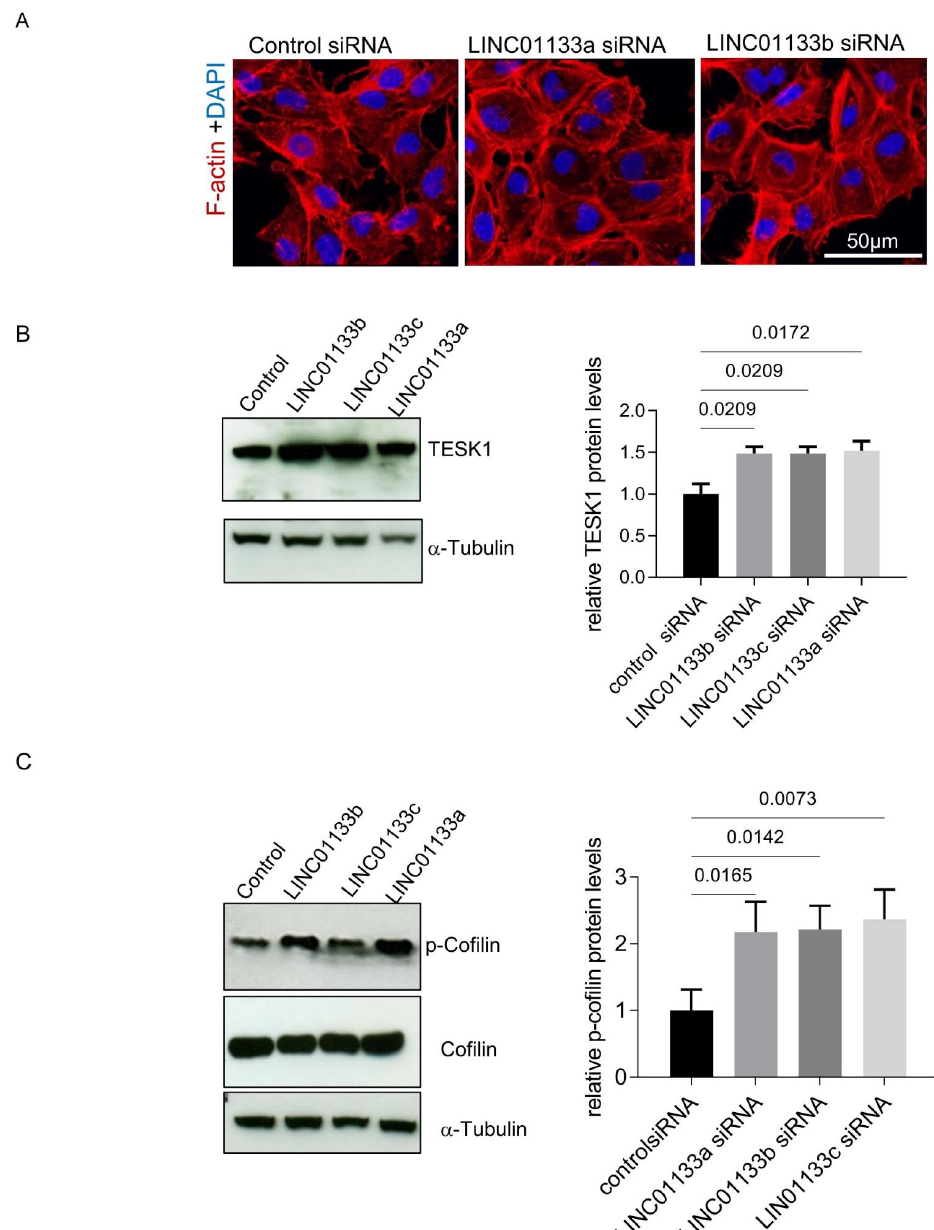
Figure 5. LINC01133 knockdown affects cellular morphology of 12Z cells ( A ) Immunofluorescence of F-actin 72 h after transfection with siRNA control and 2 different LINC01133 oligos shows a more flattened phenotype and an increase in the number of actin stress fibers. Representative confocal images are shown (three independent experiments were analyzed). Cell nuclei were visualized with DAPI. The magnification scale of 50 µ m is indicated with white line on the figure. ( B ) LINC01133 knockdown leads to upregulation of the levels of TESK1 protein. Left: Representative Western blot showing TESK1 levels together with the α -tubulin loading control. Right: TESK1 relative protein levels normalized to α -tubulin determined by densitometric analysis of Western blots. The relative levels of TESK1 from three independent experiments are shown as bar graphs with the control set to 1 and the mean and + SD of protein shown ( C ) LINC01133 knockdown increases the levels of Cofilin phosphorylation. Left: Representative example of p -Cofilin and Cofilin levels detected by Western blot with α -tubulin loading control. Right: Phosphorylated Cofilin relative levels normalized to α -tubulin determined by densitometric analysis of Western blots. The relative levels of phosphorylated Cofilin from three independent experiments are shown as bar graphs with the control set to 1, and the mean and +SD of protein shown. Statistically significant differences between the groups are indicated by adj p -values on the top of each graph (ANOVA, with Dunnett’s multiple comparison